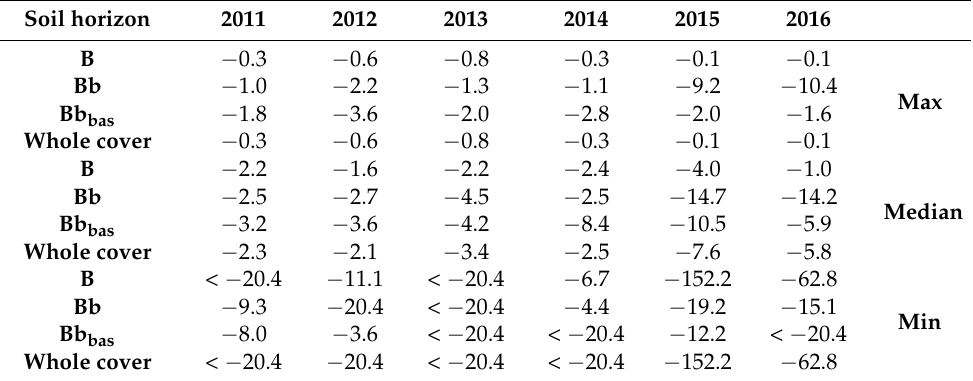
Table 4. Descriptive statistics of soil pressure head data recorded for the whole pyroclastic fall soil mantle (Whole cover) and single soil horizon (except for C) during the monitoring period 2011 −